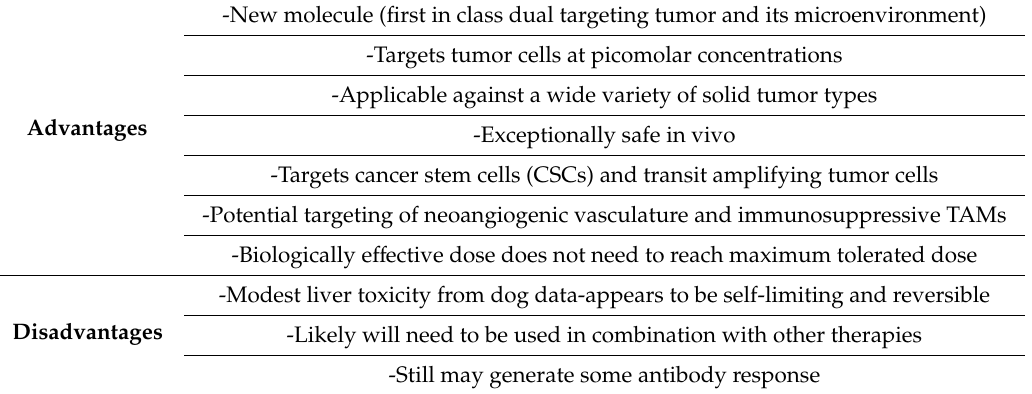
-Modest liver toxicity from dog data-appears to be self-limiting and reversible -Likely will need to be used in combination with other